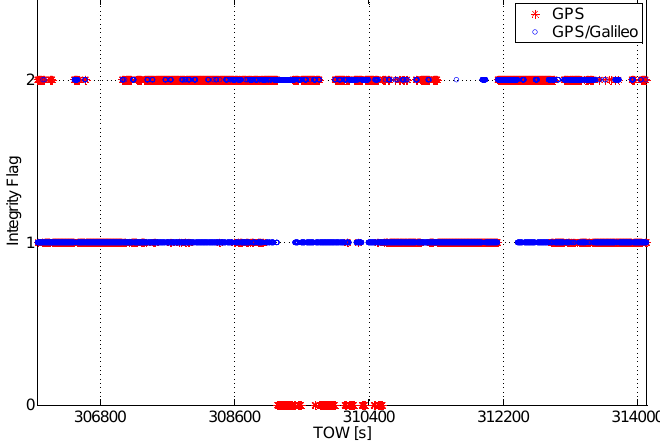
Figure 6. Integrity flag as a function of time. The flag is set to zero when it is not possible to test the reliability of the solution, and one implies a reliable solution, while two indicates an unreliable solution.